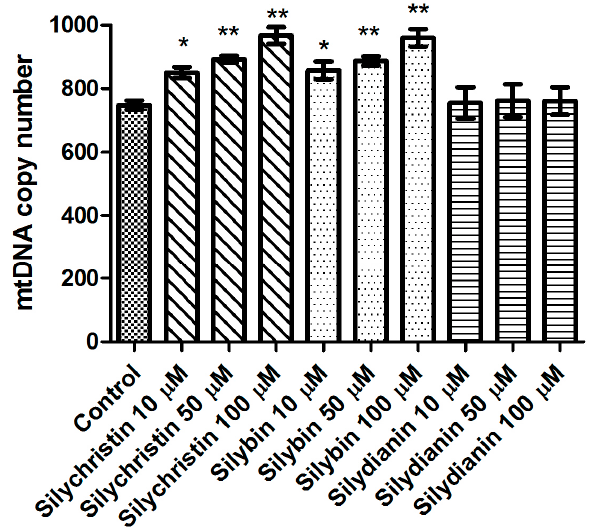
Figure 6. The effect of flavonolignans (silychristin, silybin and silydianin in concentrations of 10, 50 and 100 µM) on mitochondrial DNA copy number in an A549 cell line measured by real-time quantitative PCR. The data represent means of ± SD, n = 8. Statistical analysis was performed using the Kruskall-Wallis Test, * p < 0.05, ** p < 0.001.